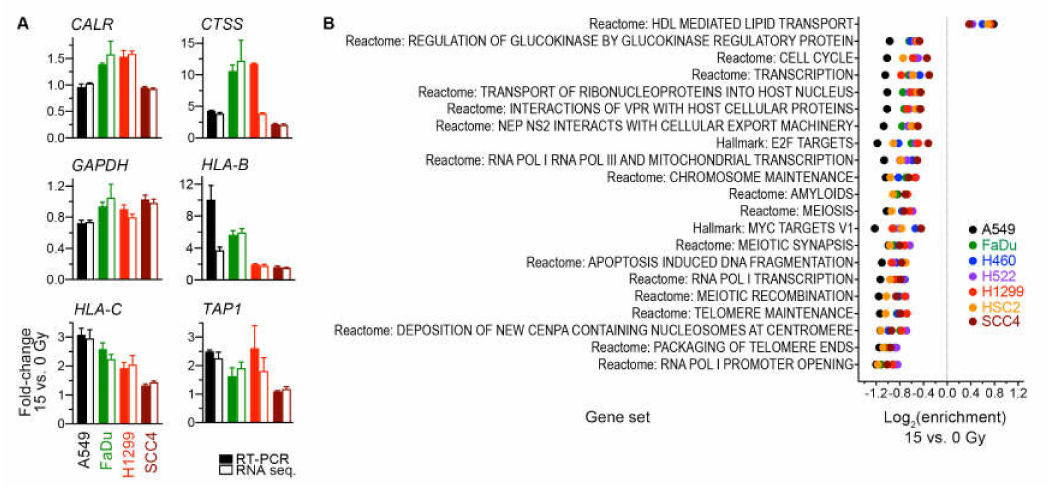
Figure 6. ( A ) Validation by reverse transcription (RT)-PCR of radiation-induced gene expression changes that were determined from RNA sequencing data. Mean of fold-change values and its standard error for pairs of 15-Gy-treated and untreated cells of three independent experiments are shown for six genes. The same RNA preparations were used for both RNA sequencing and RT-PCR. Global gene expression measurements by RNA sequencing were processed with the trimmed median of M-values method into count per million values. All values were normalized against those for the housekeeping ACTB gene prior to fold-change calculations. ( B ) Analyses of radiation-induced gene expression changes at the gene set level. Enrichment for 21 significant gene sets ( p < 0.05) with similar enrichment across all seven indicated cell lines is shown. Gene expression of the 15-Gy-treated and untreated cells for Molecular Signature Database Hallmark and Reactome gene sets was scored using the gene set variation analysis method. Enrichment for a gene set was calculated as the ratio of scores of the groups of cells, and its statistical significance was estimated with a paired, empirical Bayes-moderated t